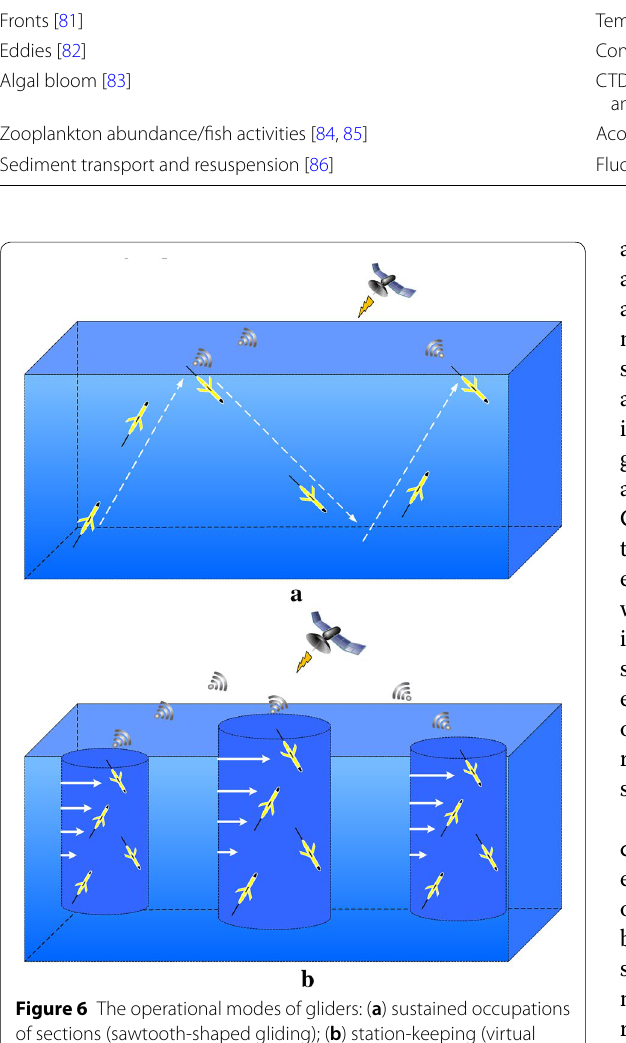
sustained occupations of sections [81], and as survey tools in limited-duration process studies [89]. The sche- matic diagrams of the operational modes are shown in Figure 6. The first operational mode of gliders is pro- spective to replace expensive moored buoys at desig- nated sites to sample water column and air-sea coupled parameters for whether prediction, and the latter two applications lead the design toward persistent sampling of the oceanic mesoscale, resolving scales of kilometers